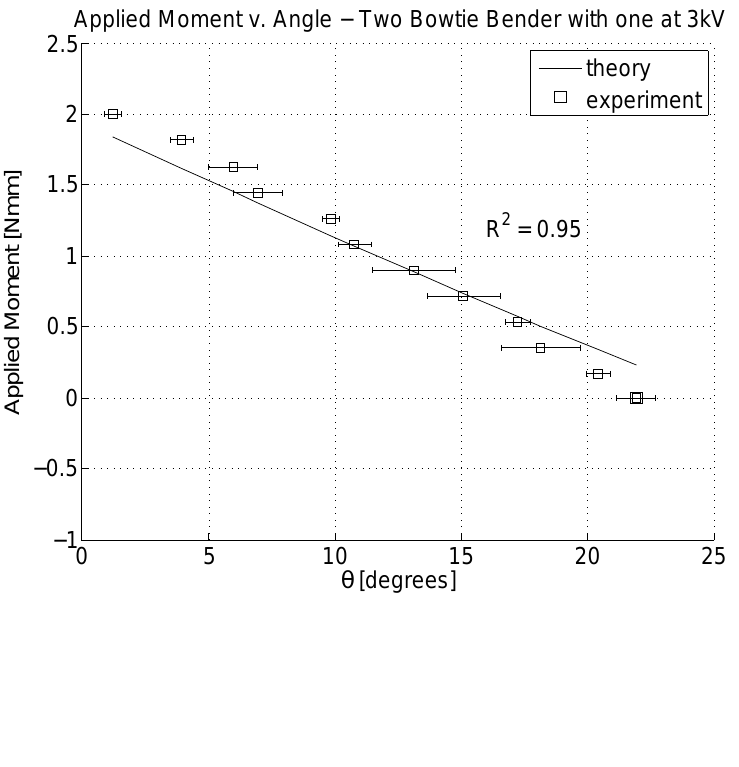
Figure 16. Model fit to data for a two bowtie